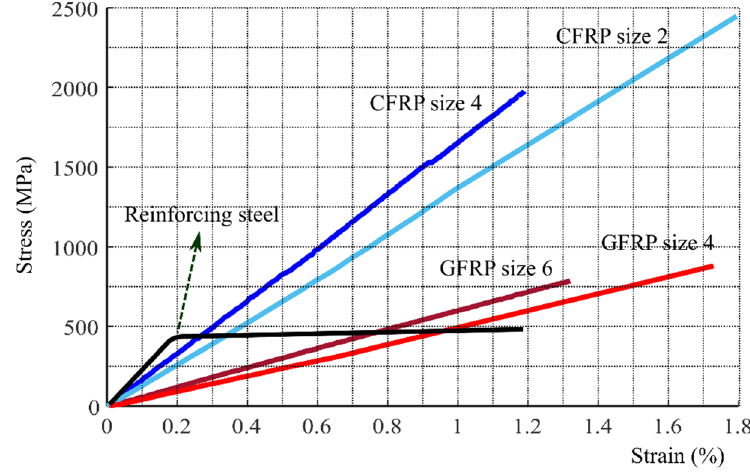
Figure 1. Stress-strain characteristics of various types of reinforcement.